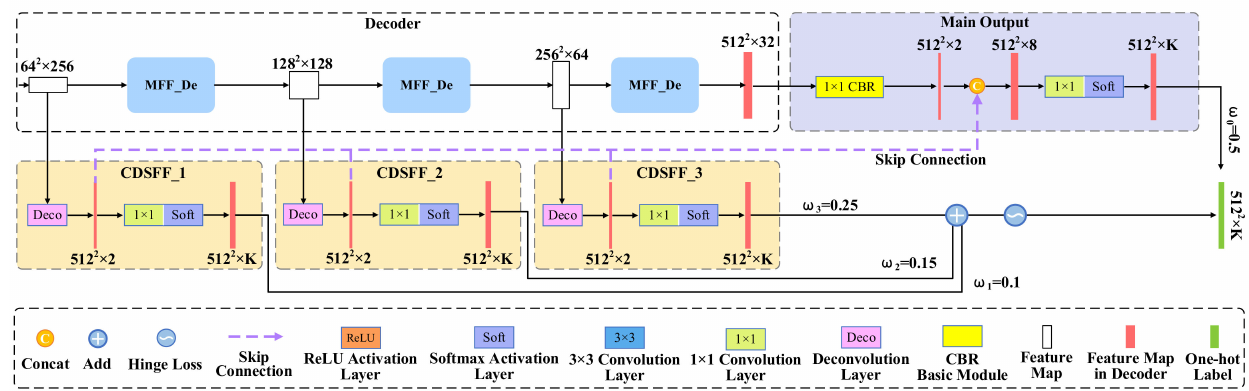
Figure 4. The CDSFF structural diagrams in CSD-Net. The four feature maps with different levels are coupled by CDSFF_1, CDSFF_2, CDSFF_3, and the Main Output structure in the decoding